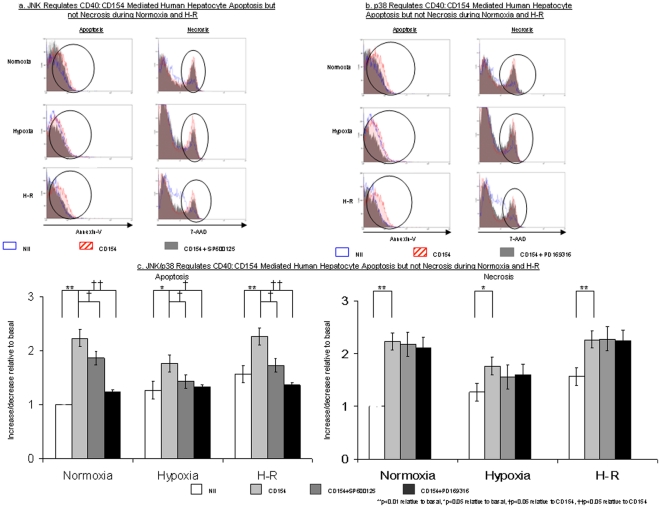
JNK and p38 regulate CD40∶CD154 mediated human hepatocyte apoptosis but not necrosis.
Figure 3a show representative flow cytometry plots to illustrate the effect of the JNK inhibitor SP600125 upon CD40∶CD154 mediated apoptosis and necrosis during normoxia, hypoxia and H-R. The gate used to analyse primary human hepatocytes is the same as that shown in Figures 1 & 2. The area of interest within the flow cytometric plots are marked by the vertical ellipses. Figure 3b illustrates the effects of the p38 inhibitor P169316 upon CD40∶CD154 mediated apoptosis and necrosis during normoxia, hypoxia and H-R. Figure 3c shows a bar chart with the pooled data of three separate experiments illustrating the effects of both SP600125 and PD169316 upon CD40∶CD154 mediated human hepatocyte apoptosis and necrosis during normoxia, hypoxia and H-R. Data are expressed as increase/decrease relative to basal, where basal refers to the level of apoptosis or necrosis during normoxia alone. Data are expressed as mean ± S.E. (**p<0.01 relative to basal, *p<0.05 relative to basal, †p<0.05 relative to CD154, ††p<0.05 relative to basal).